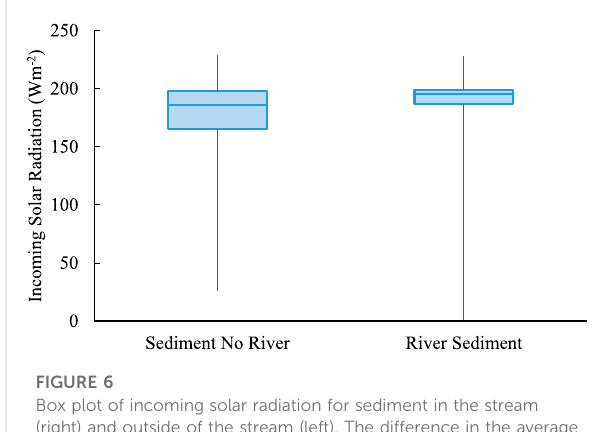
FIGURE 5 Relationship between stream width and average sediment cover for each meter of the main channel that falls within the small scene where all seven fl ights